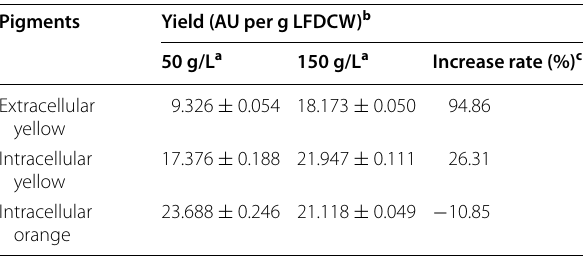
Table 1 Pigment yield per unit LFDCW and yield